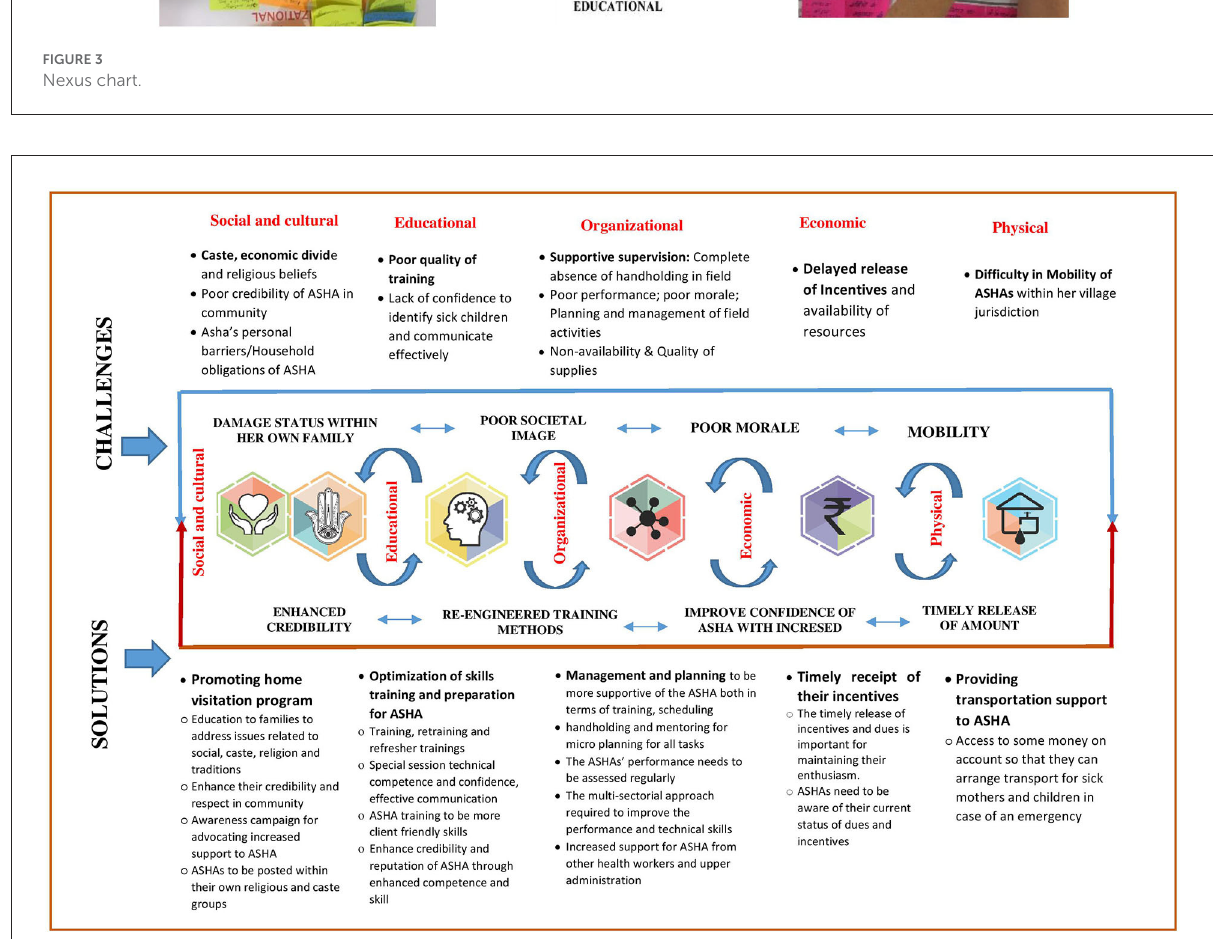
FIGURE4 The challenges and solutions to improve ASHAs postnatal home visits.